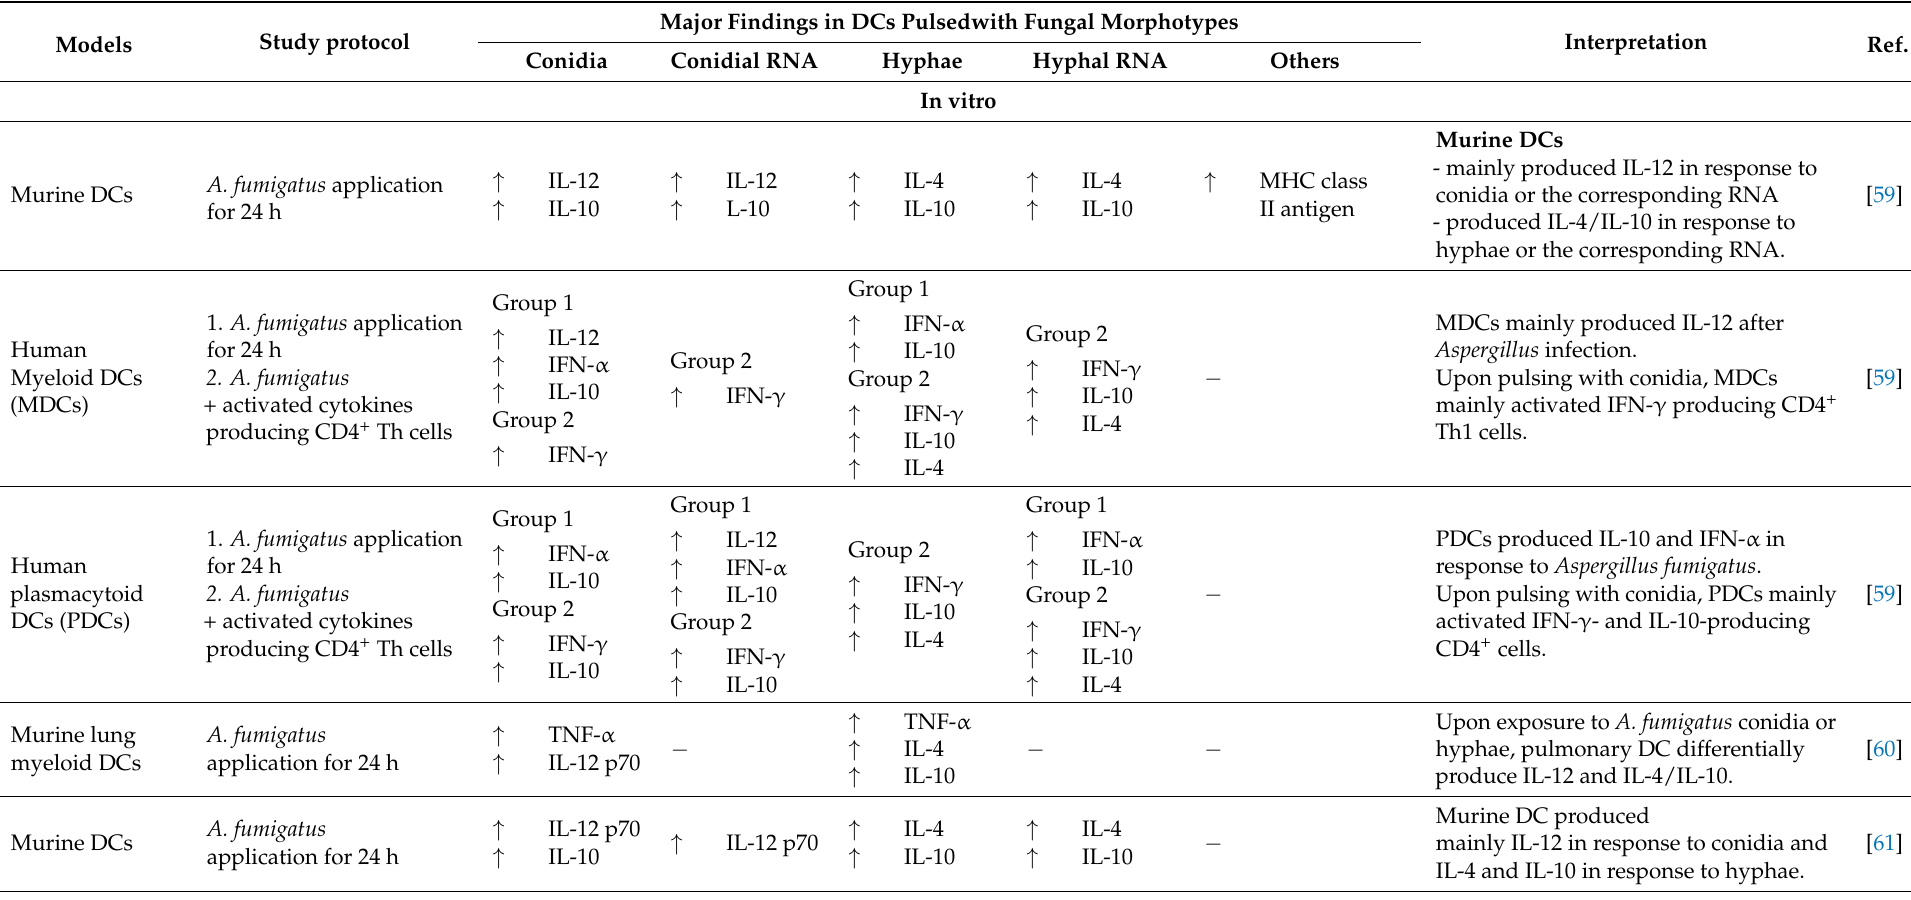
Table 4. Perspective of vaccine development using dendritic cells (DCs) activation and its impact on cytokine levels in invasive